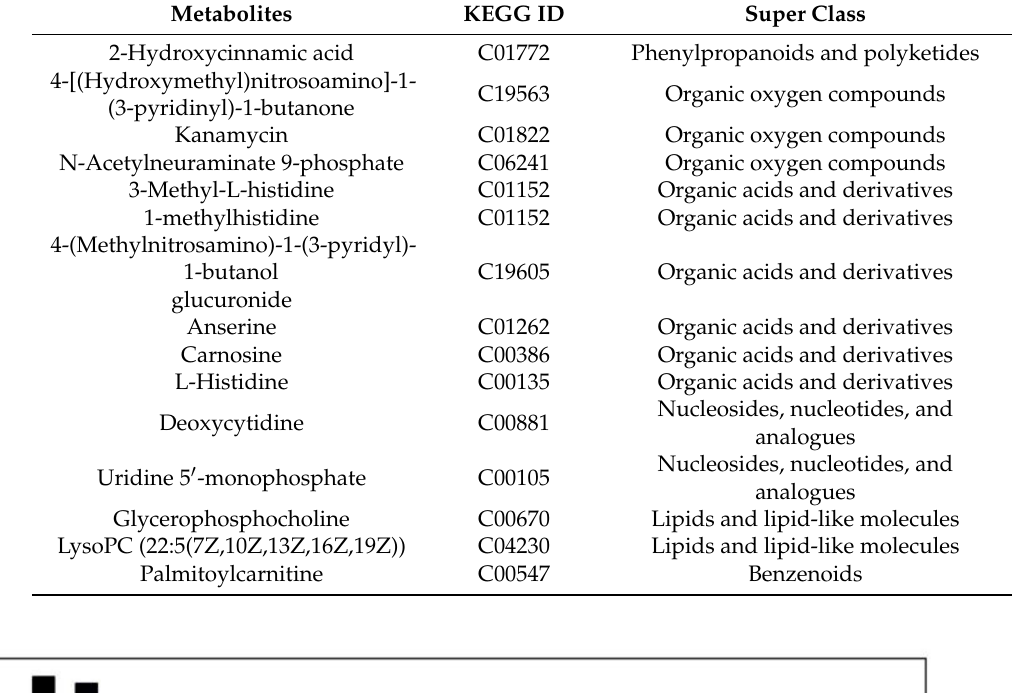
Figure 5. Statistical chart of upregulated ( a ) and downregulated differential metabolites ( b ).